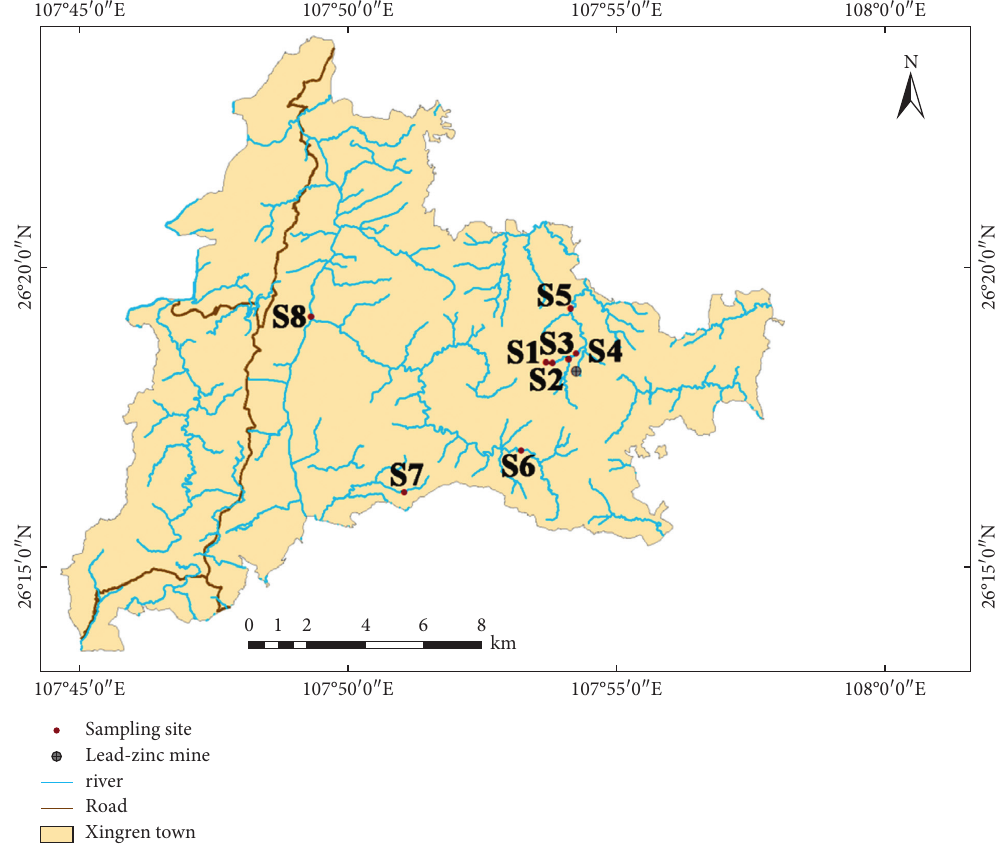
Figure 1: Study area and the location of 8 sampling Table 1: The descriptive of HMs in the sediments around this lead-zinc mine (mg kg − 1 ). HMs Maximum Mean ± std. Coefficient of variation (%) Background values